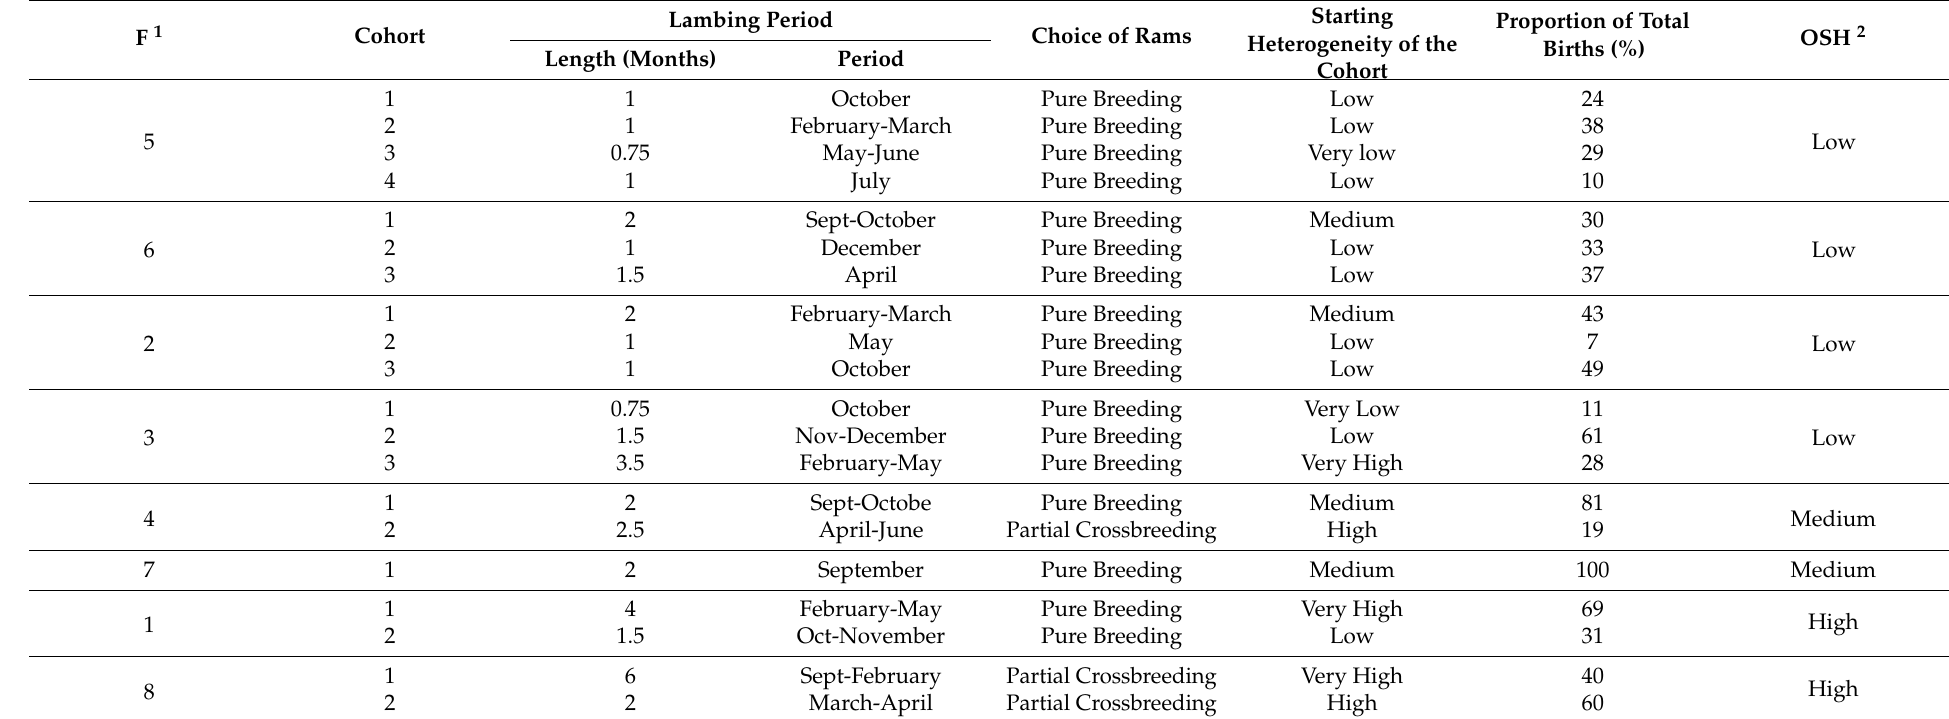
Table 3. Overall starting heterogeneity for the eight sheep meat farmers